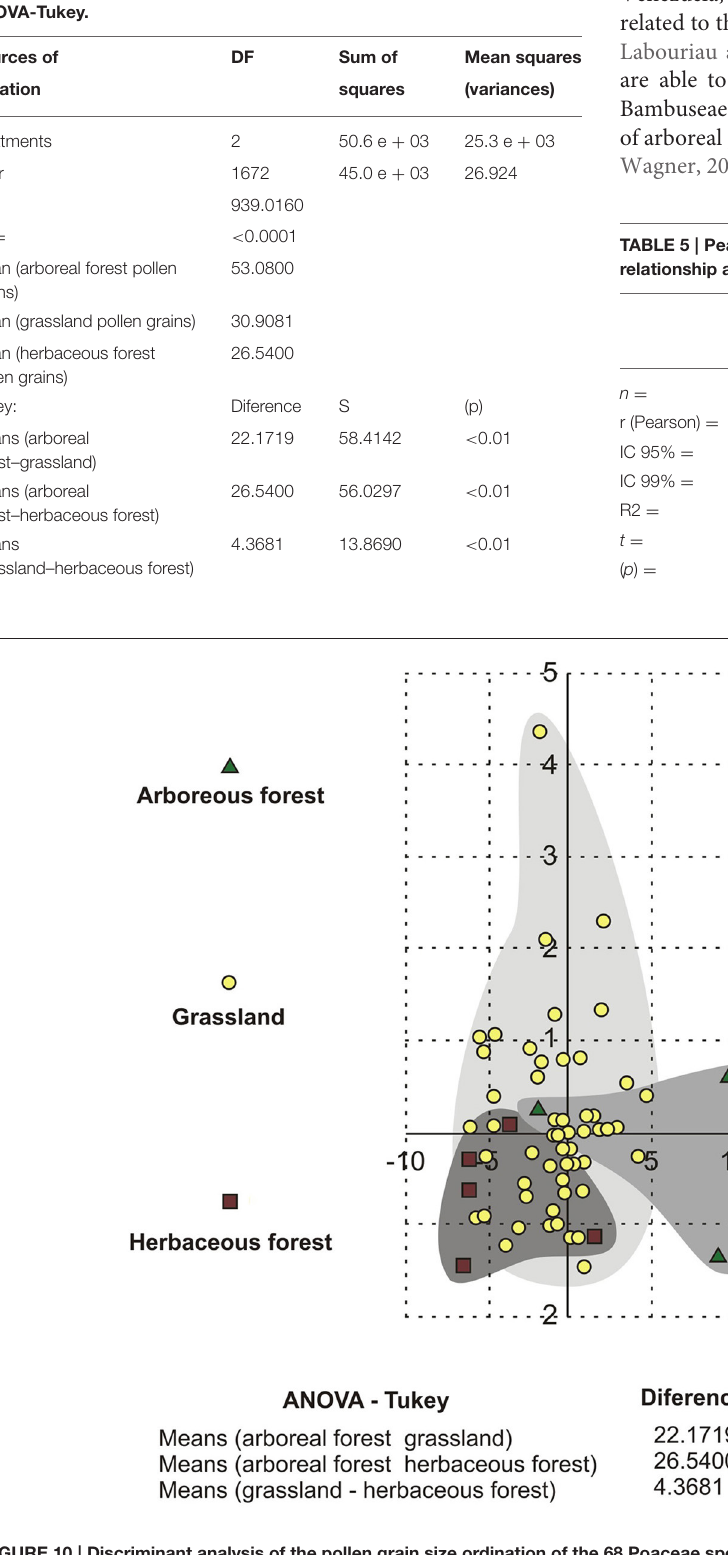
Frontiers in Plant Science |